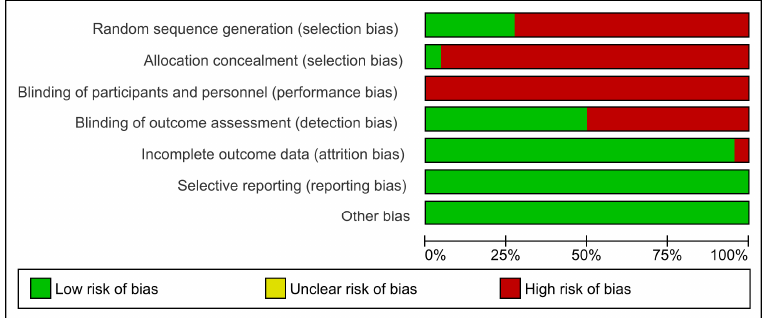
Figure 2. Risk of bias graph: review authors’ judgments about each risk of bias item presented as percentages across all included studies.